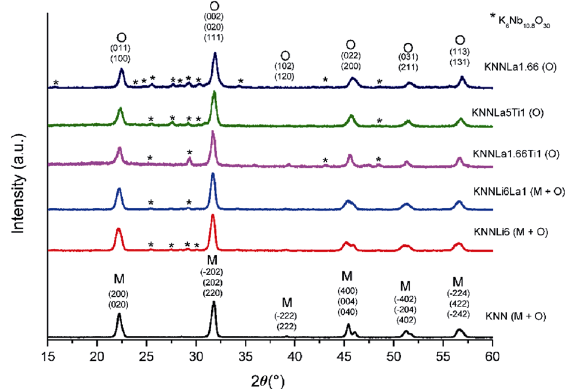
Fig. 1 Diffraction patterns of ceramic samples. M and O stand for the monoclinic and the orthorhombic phases, respectively.